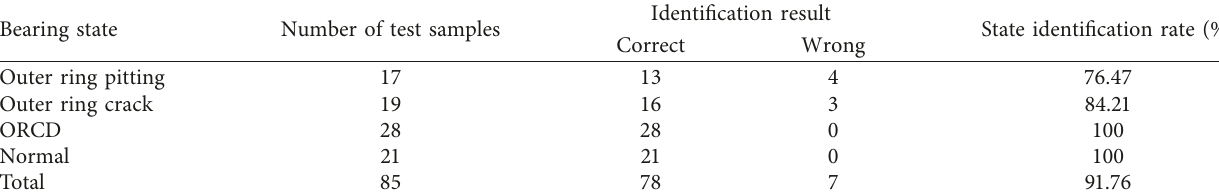
Table 7: Test set identification